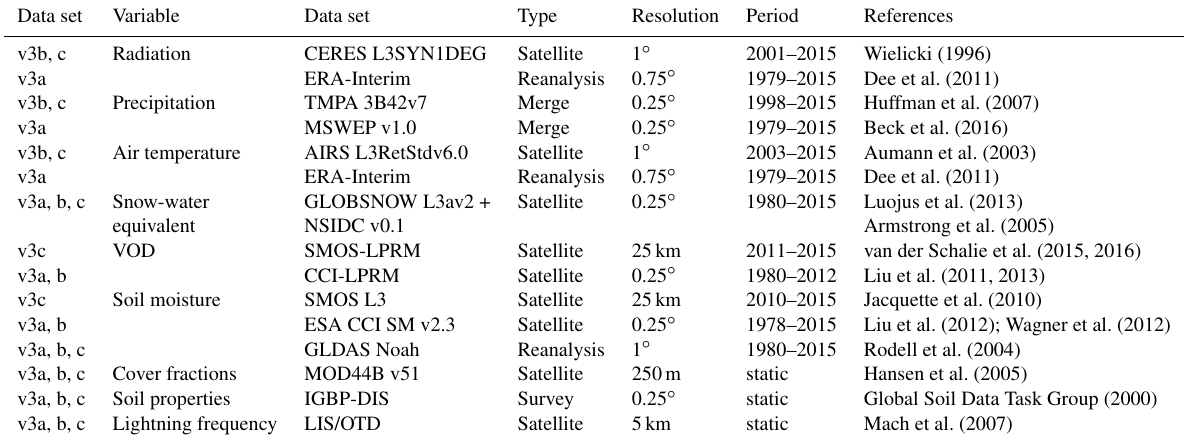
Table 1. List of the selected forcing data sets together with their references, the original spatial resolution, and period of availability. The first column indicates the use of these data in